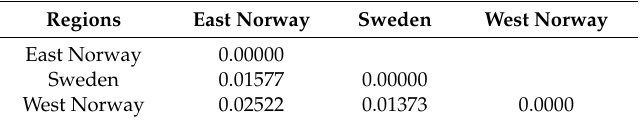
Table 5. Pair-wise F ST values among the three sampling locations of Argyresthia conjugella in the